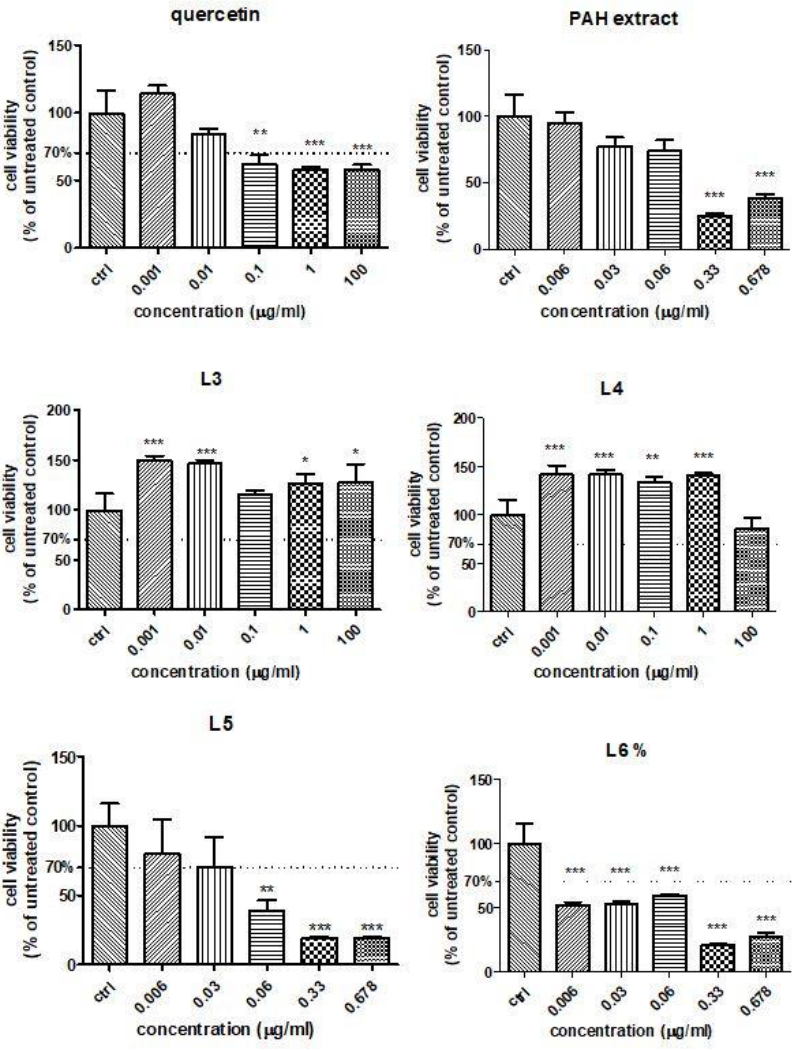
Figure 4. Cell viability of HUVECs treated with quercetin, PAH extract and different liposome formulations with quercetin and the PAH extract. HUVECs were exposed to quercetin and L3 and L4 formulations in concentrations ranging between 0.001-µg GAE/mL and 100-µg GAE/mL and to the PAH extract and L5 and L6 formulations in concentrations between 0.006-µg GAE/mL and 0.678-µg GAE/mL (data are presented as the mean of OD540 ± SD; n = 3 for each sample). * p < 0.05, ** p < 0.01 and *** p < 0.001 vs. control, untreated cells.